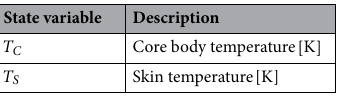
Table 1. State variables for model (1),